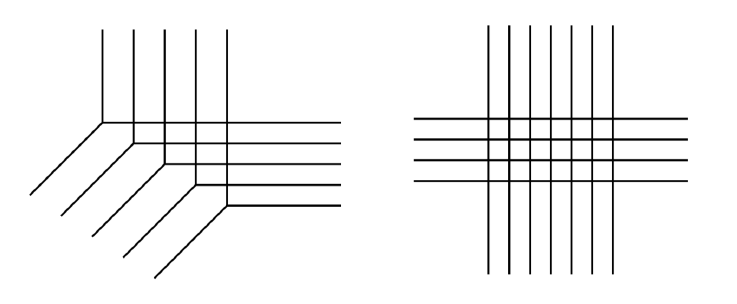
Figure 1 . Left: brane web for the T N theory. Right: brane web for the + M,N